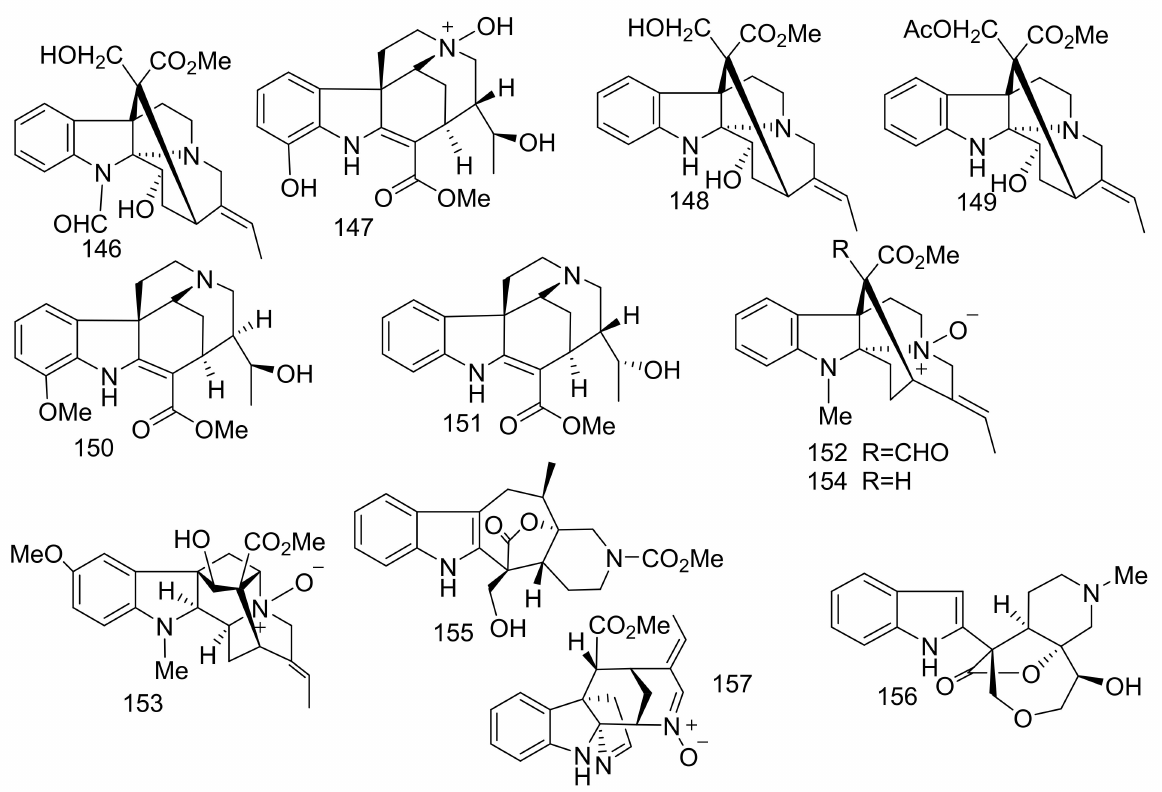
Figure 17. Compounds 146 – 157